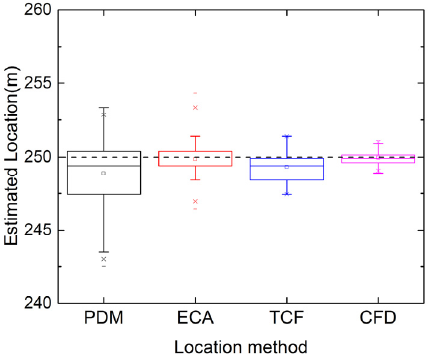
Figure 11. Statistical analysis of different location methods under SNRs = 15 dB.